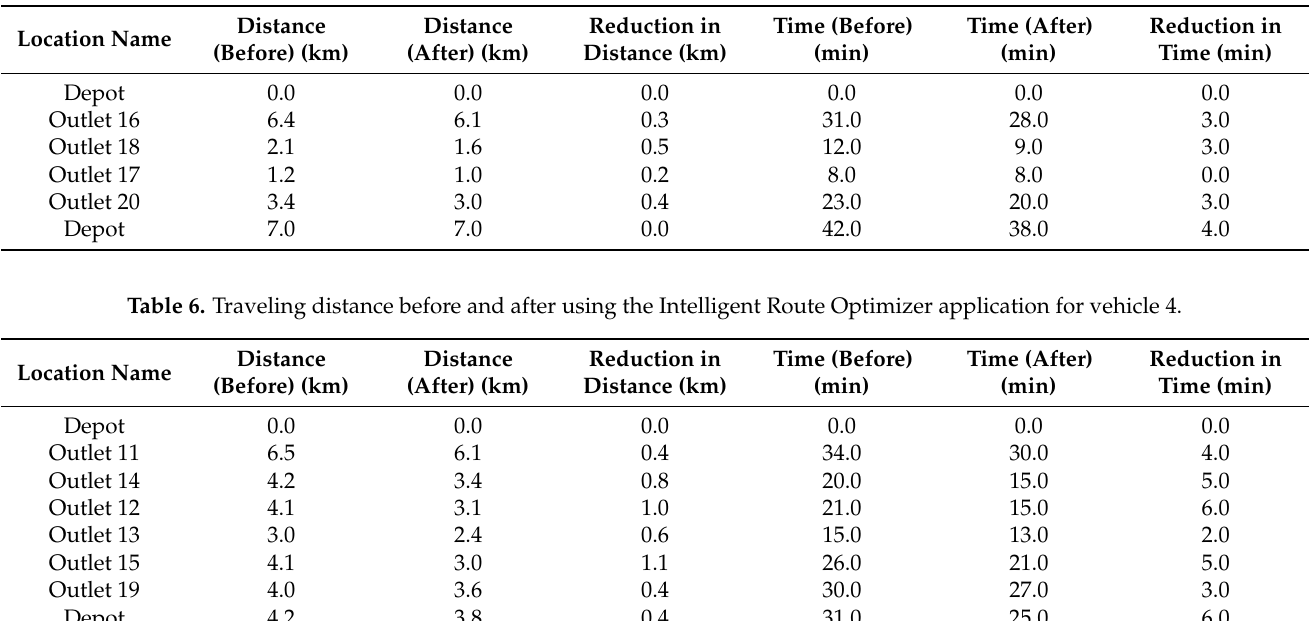
Table 5. Traveling distance before and after using the Intelligent Route Optimizer application for vehicle 3.